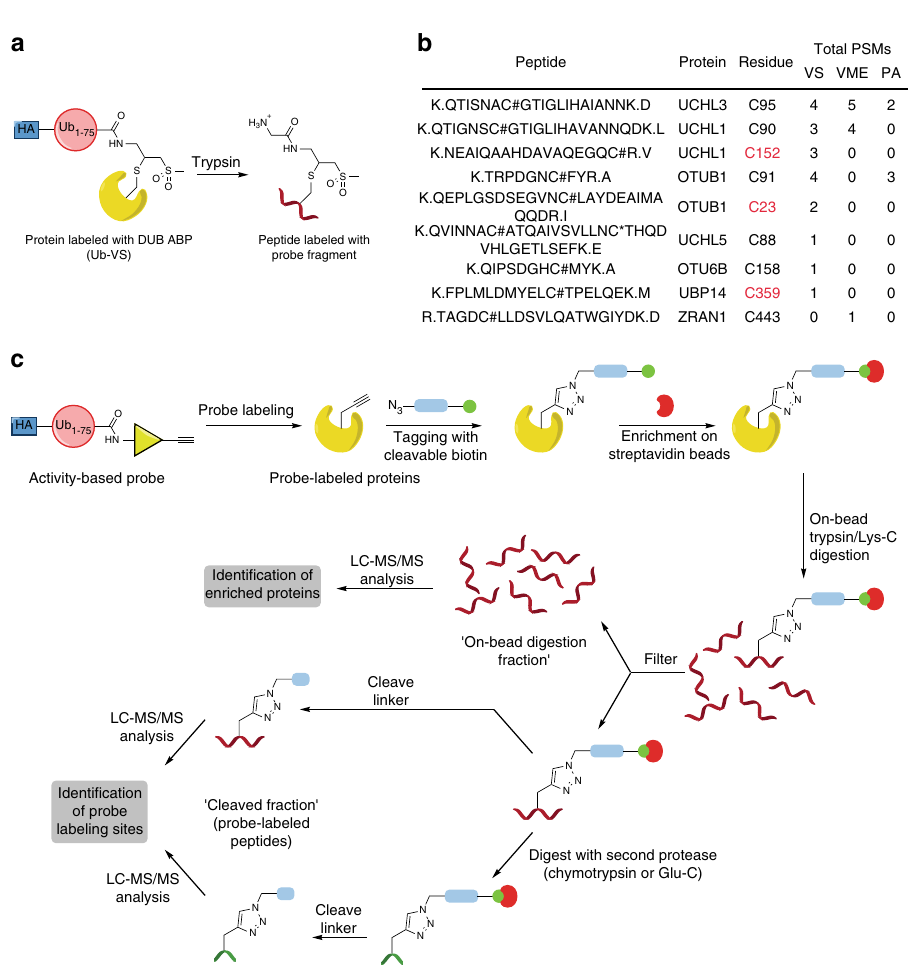
Fig. 1 Conventional DUB ABPs label DUBs on both catalytic and non-catalytic Cys residues. a Structure of probe-labeled peptide fragment generated by trypsin digestion of Ub-VS-labeled proteins. In these ABPs, an HA tag is attached to residues 1 – 75 of ubiquitin by a spacer of two aminohexanoyl units. b Detection of probe-labeled DUB peptides in HEK 293T lysate after anti-HA immunoprecipitation and fi lter-assisted sample preparation (FASP), using HA-tagged Ub-VS, Ub-VME, or Ub-PA probes. Peptides were searched using the probe fragment as a variable modi fi cation on Cys. (Modi fi cation on other residues could not be detected.) Non-catalytic Cys residues are shown in red. # = Ub-probe fragment; * = carbamidomethyl modi fi cation; @ = methionine oxidation. c Reactive-site-centric chemoproteomic strategy to identify probe targets and labeling sites. Lysates are treated with an alkyne-containing ABP. Click chemistry is used to attach a cleavable biotin-azide tag and tagged proteins are enriched on streptavidin beads, using stringent washing to remove non-covalent binders. Proteins are digested on-bead to provide peptides for protein identi fi cation. The beads are then subject either to immediate linker cleavage to release probe-labeled peptides or to a second proteolysis before linker cleavage. The yellow triangle represents an electrophilic group, the pale blue rectangle represents a cleavable linker, and the green circle represents